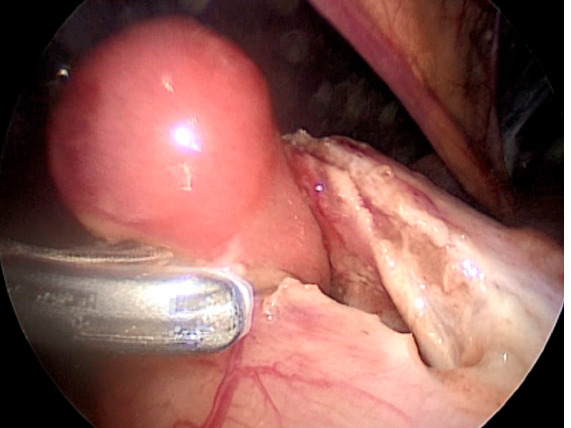
Figure 5. Laparoscopic gastrotomy and polypectomy (pancreatic tissue ectopy in the stomach) under the guidance of endoscopist.